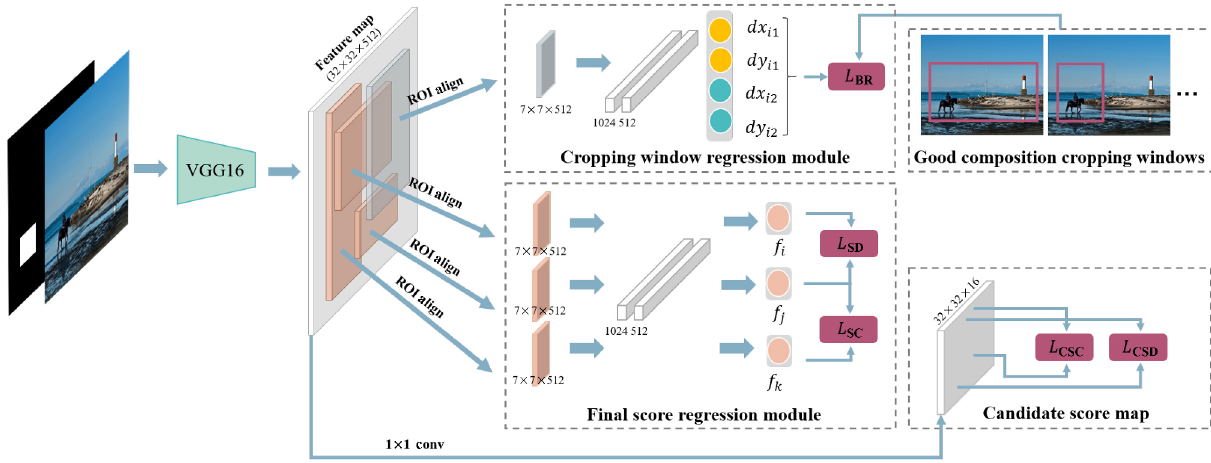
Fig. 5 SAC-Net training pipeline. During training, the candidate score map, cropping window regression module, and final score regression module calculate different losses. The candidate score map and final score regression module are supervised by ranked pairs; the cropping window regression module is supervised by good composition cropping windows. Losses of each module not only affect that module, but also the